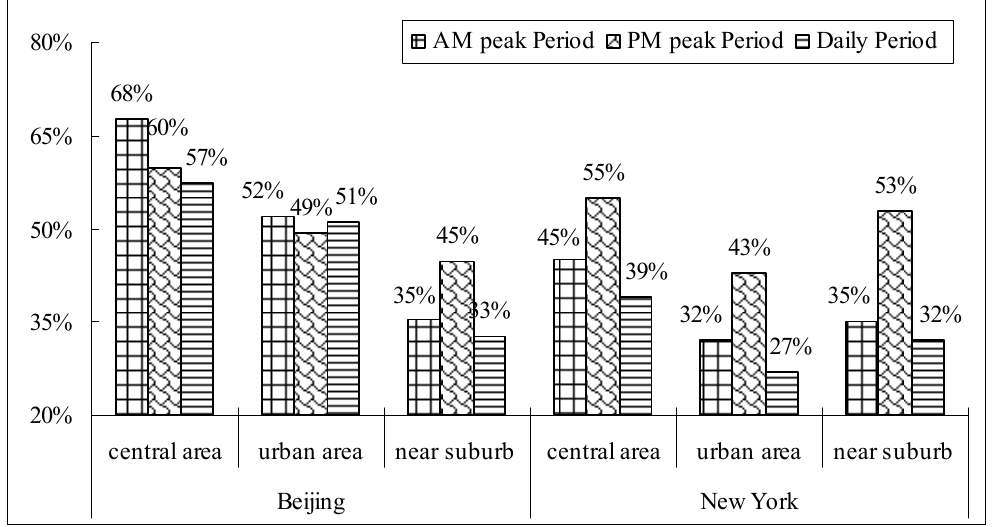
Fig. 2. V/C ratio comparison of different area in Beijing and New